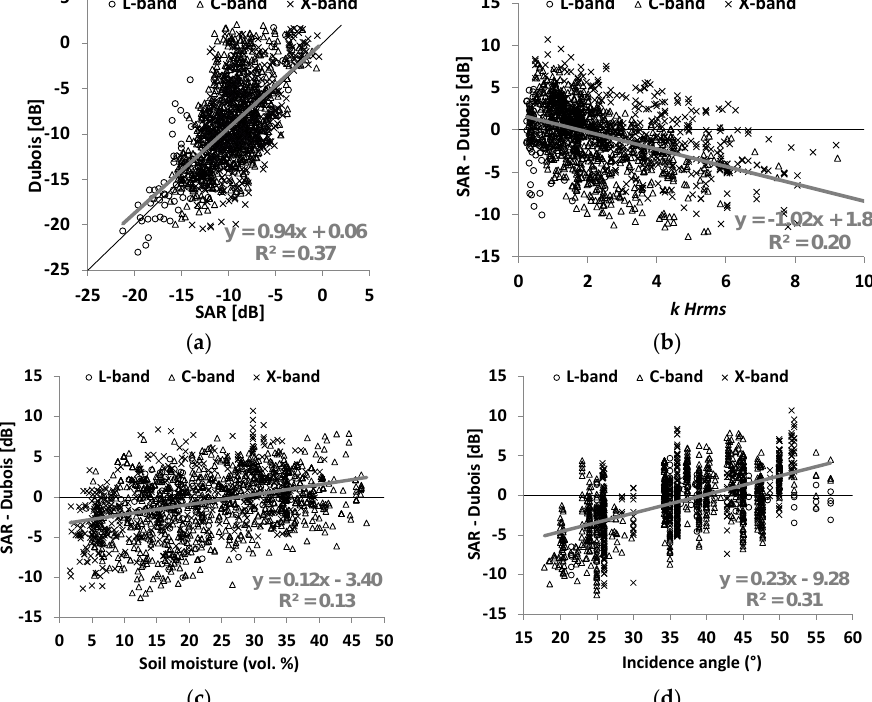
Figure 1. For HH polarization, ( a ) comparison between radar backscattering coefficients calculated from SAR images and estimated from the Dubois model; ( b ) the difference between the SAR signal and the Dubois model relative to soil roughness ( kHrms ); ( c ) the difference between the SAR signal and the Dubois model relative to soil moisture ( mv ); and ( d ) the difference between the SAR signal and the Dubois model relative to incidence angle. The best regression model is plotted in gray.